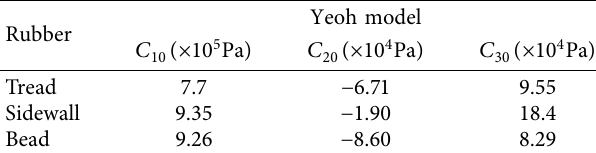
Table 2: Yeoh model parameters of